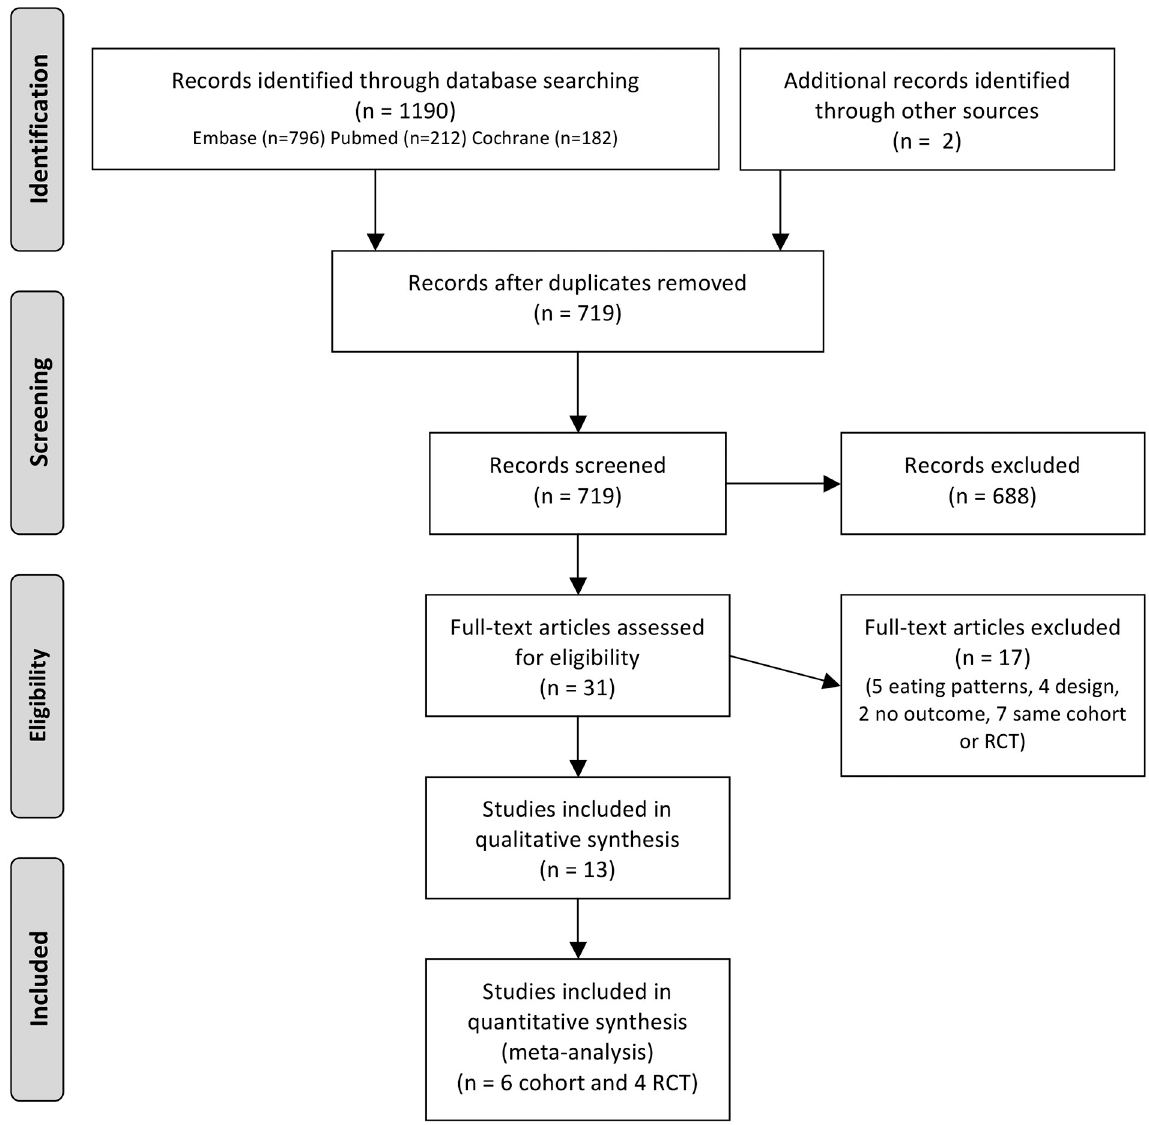
Fig 1. PRISMA 2009 flow diagram of the selection of studies included in the review. From : Moher D, Liberati A, Tetzlaff J, Altman DG, The PRISMA Group (2009), P referred R eporting I tems for S ystematic Reviews and M eta- A nalyses: The PRISMA Statement. PLoS Med